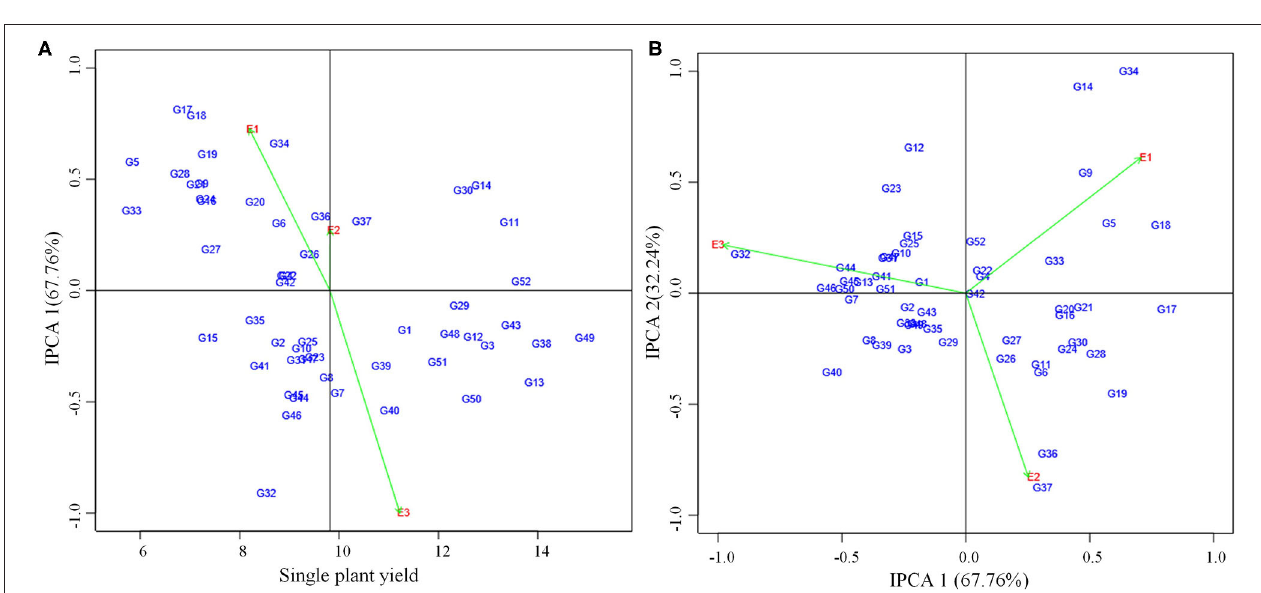
FIGURE 2 | (A) AMMI I biplot showing main effects and IPCA1 interaction effects of 52 mungbean genotypes and three environments on grain yield of mungbean. (B) AMMI II biplot of first two principal components (IPCA1 vs IPCA2) of interaction effects.